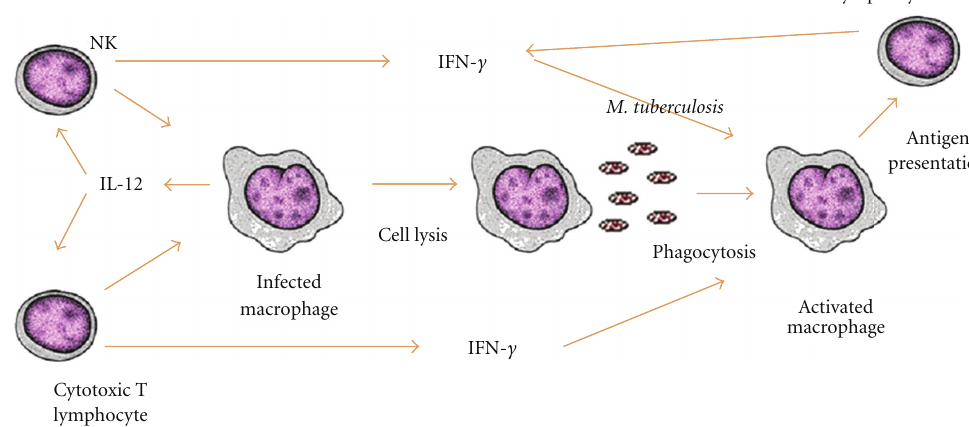
Figure 1: Initial protective response to M. tuberculosis -Th1